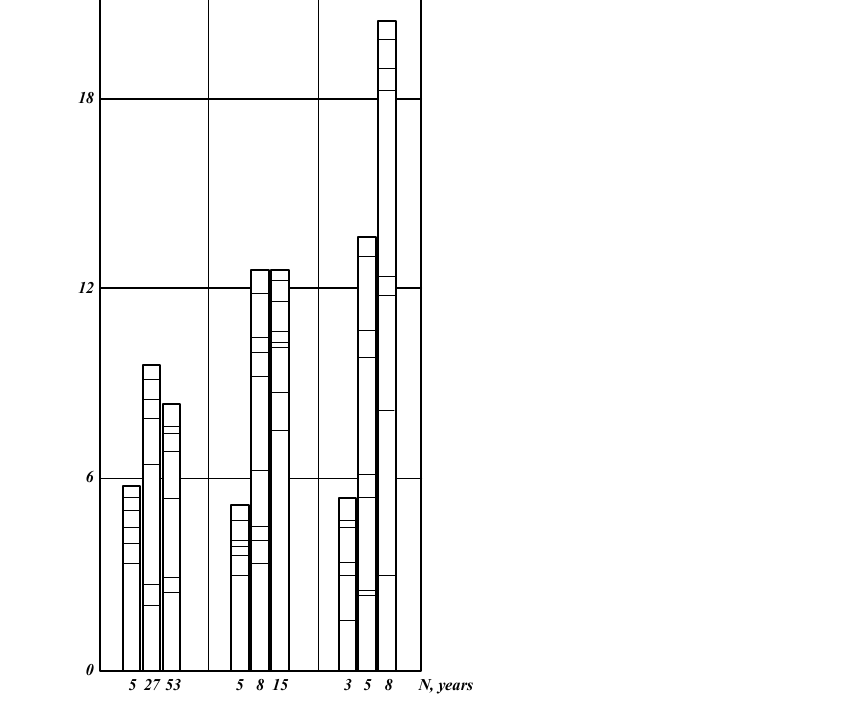
Figure 1. The amount of hydrogen in the samples, cut out from the walls of cylinders made of various steels, after the service life N [41].